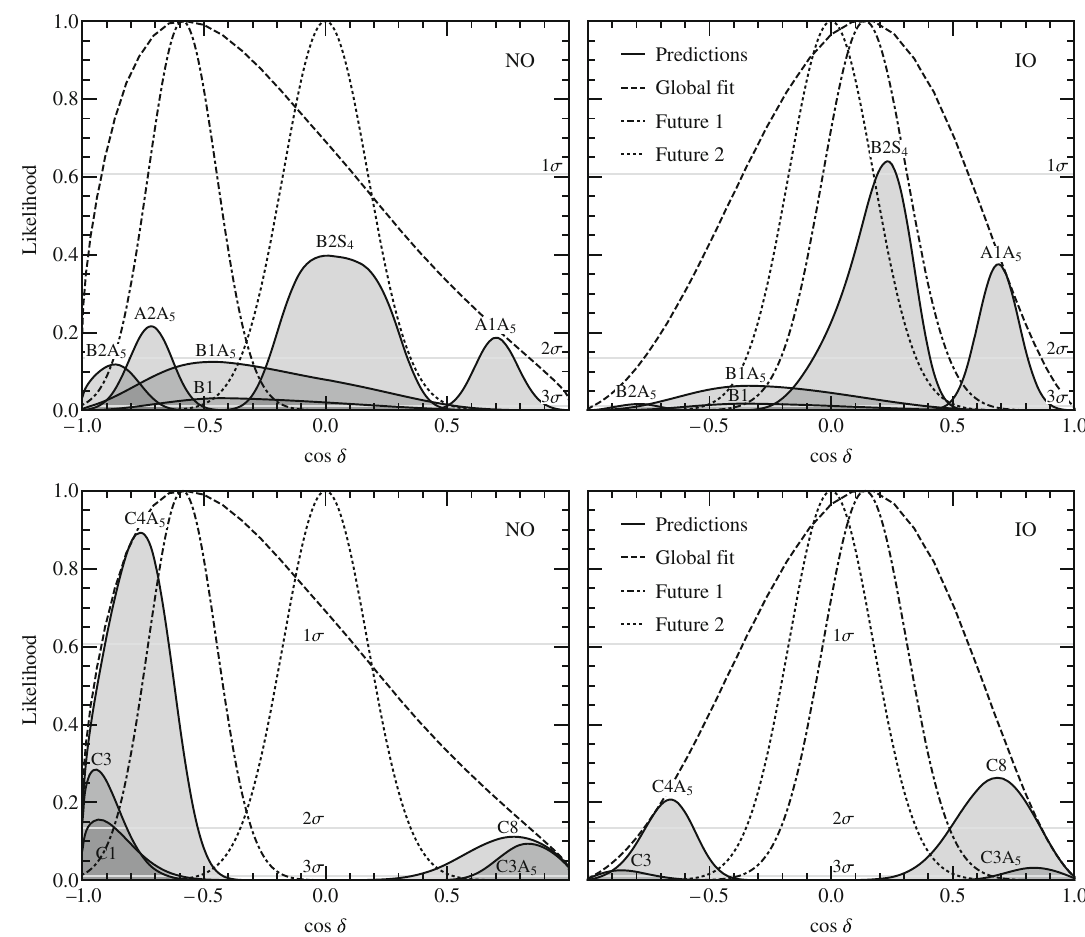
Fig. 5 Predictions for cos δ obtained using the current global data on the neutrino mixing parameters. “Future 1” refers to the scenario with δ bf = 234 ◦ ( 278 ◦ ) for NO (IO) spectrum (current best fit values) and